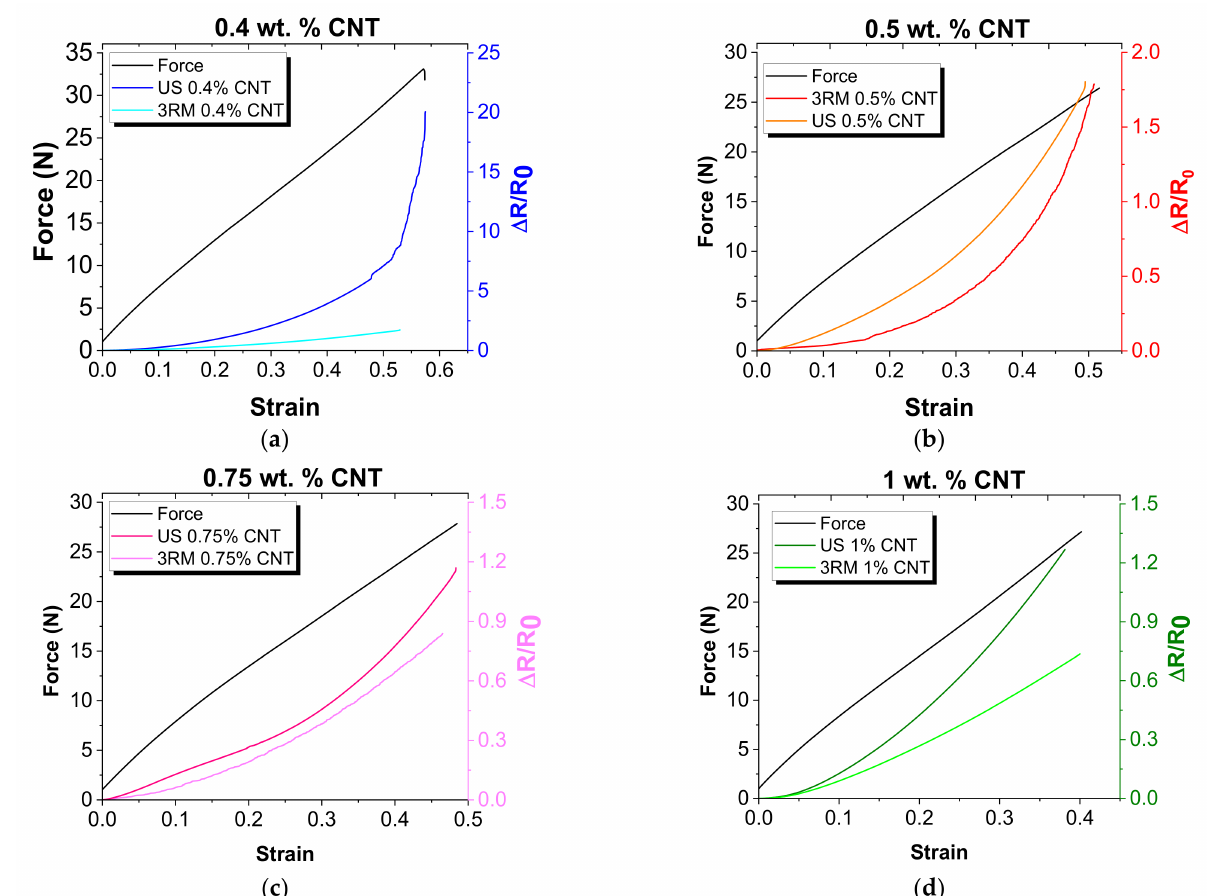
Figure 5. Strain monitoring curves of the CNT-PDMS sensors for the different manufacturing